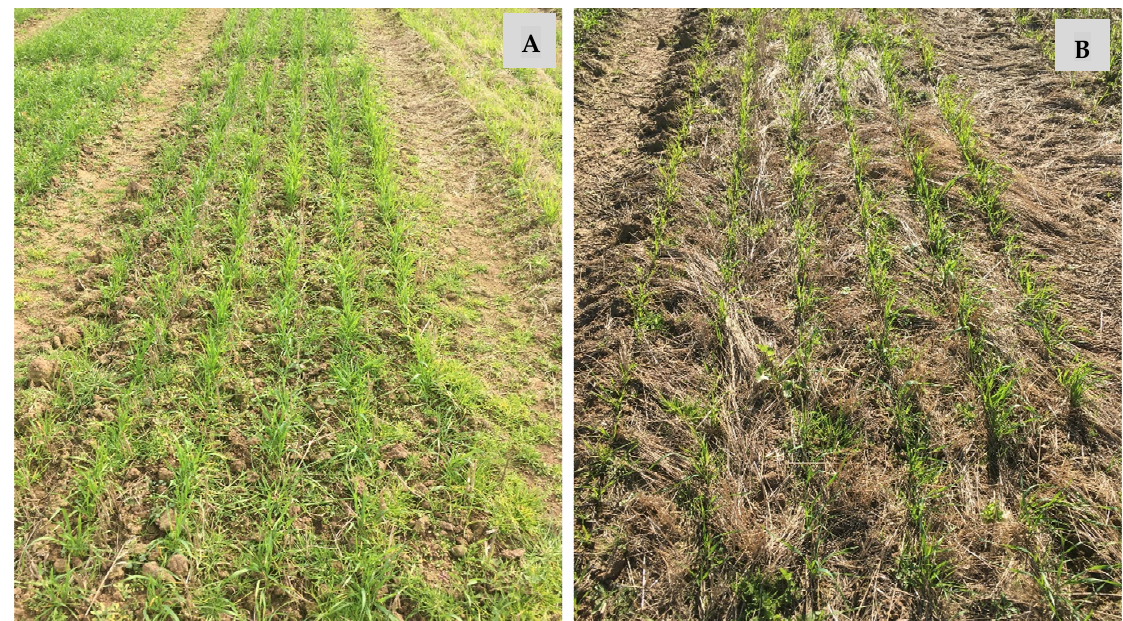
Figure 4. Density of wheat and weed plants at Bringelly ( A ) and Lansdowne ( B ). Error bars show standard error. Different letters show significant differences ( p < 0.05) (ab for weed density and x for wheat density).